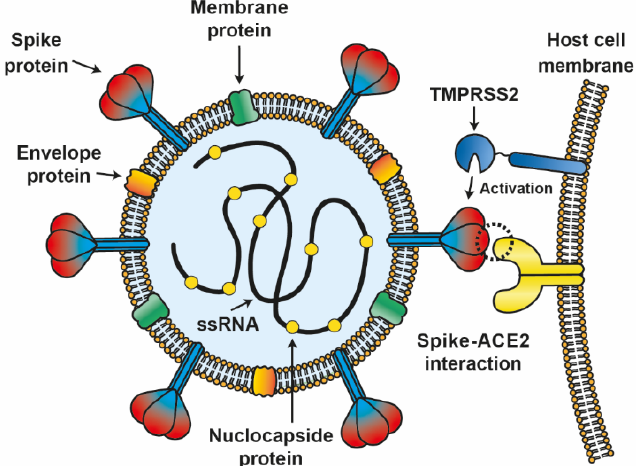
Figure 1. Interaction between SARS-CoV-2 and host cell. The SARS-CoV-2 virion is composed of 4 structural proteins, spike protein (S), membrane protein (M), envelope protein (E), and nucleocapsid protein (N), associated with single-stranded RNA (ssRNA) of the virion. S protein interacts with the host cell ACE2 protein and is activated by TMPRSS2 as part of the infection mechanism.